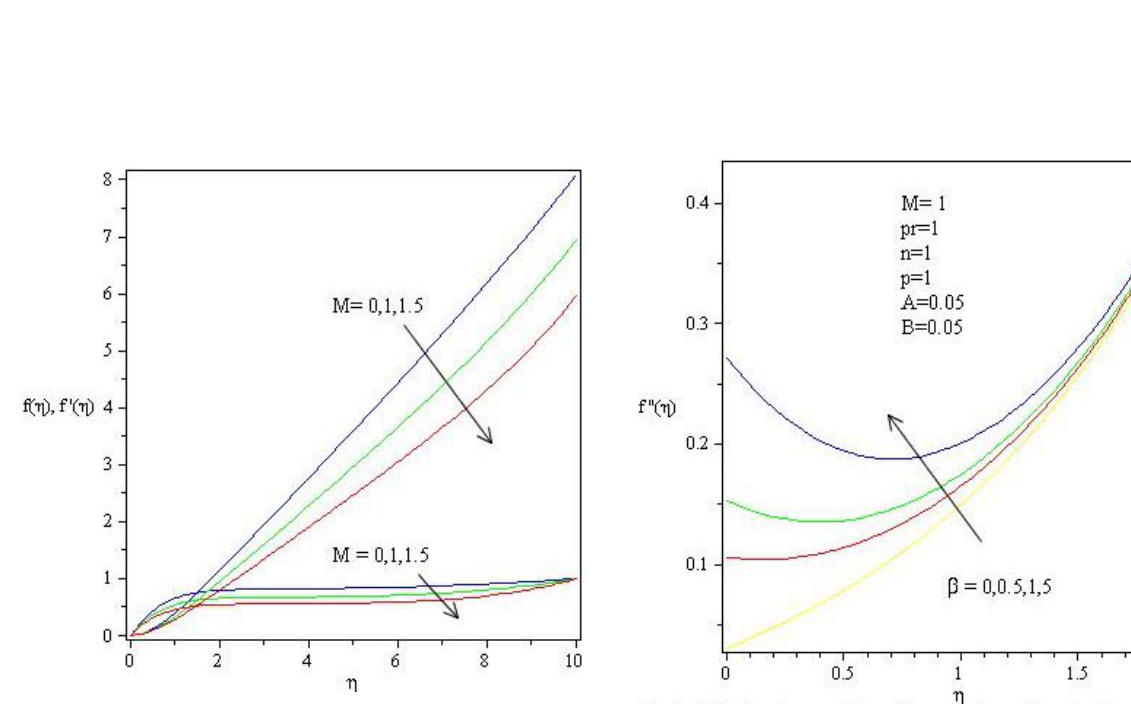
Fig. 12: Skin-friction profile for different values of β when λ = σ =